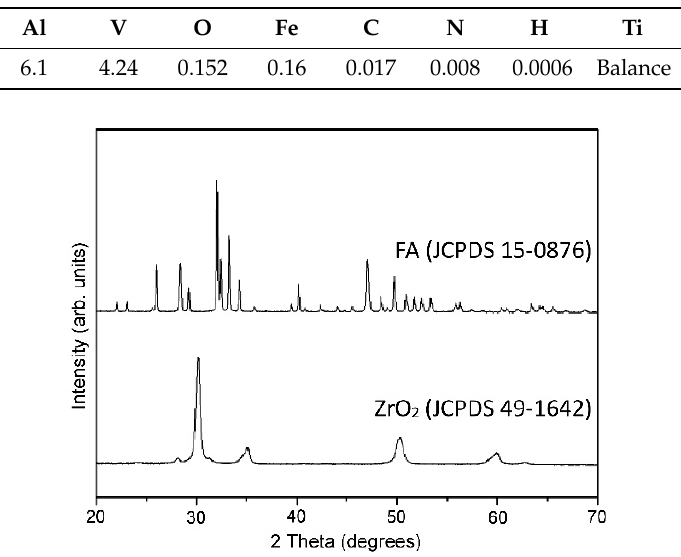
Figure 1. XRD patterns of coating powders: FA and ZrO 2 (3 mol % yttria (3Y-TZP), partially stabilized with 3 mol % Y 2 O 3 ).